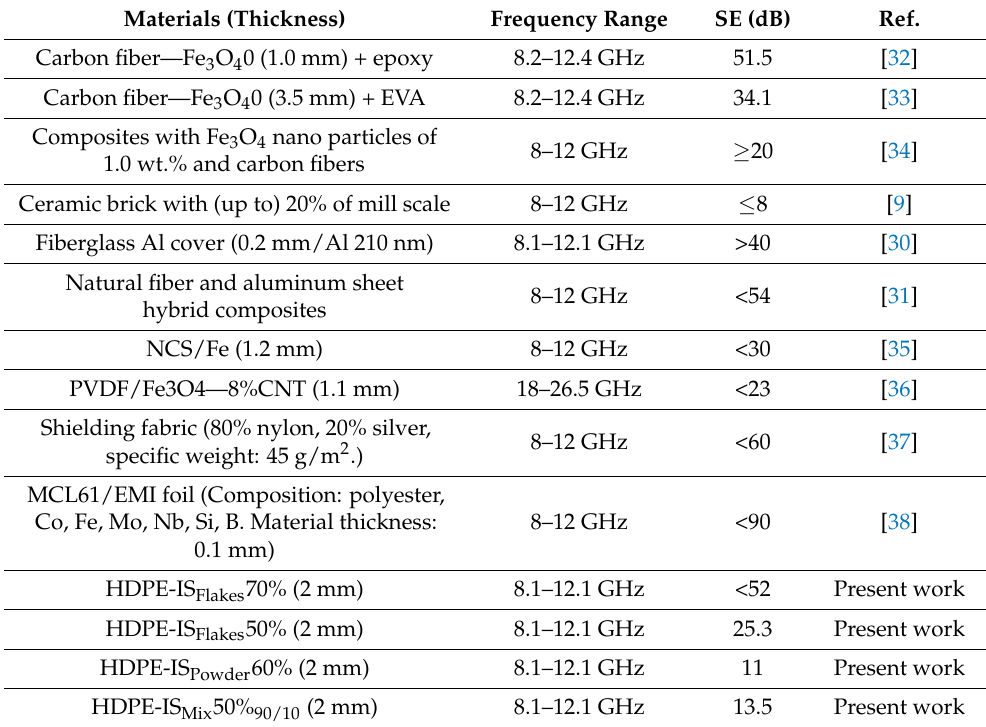
Table 2. EMI shielding properties of different composite materials reported in the